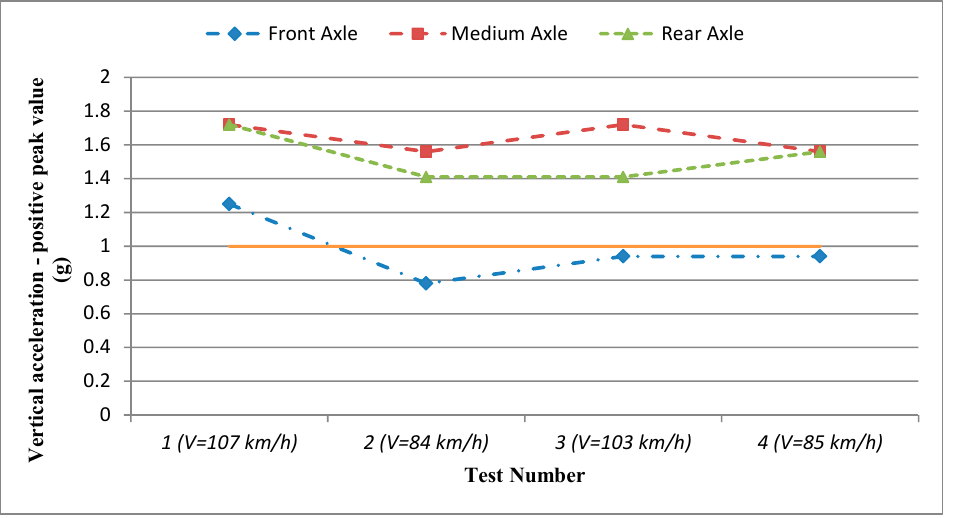
Figure 17. Maximum positive vertical acceleration values recorded during each test.